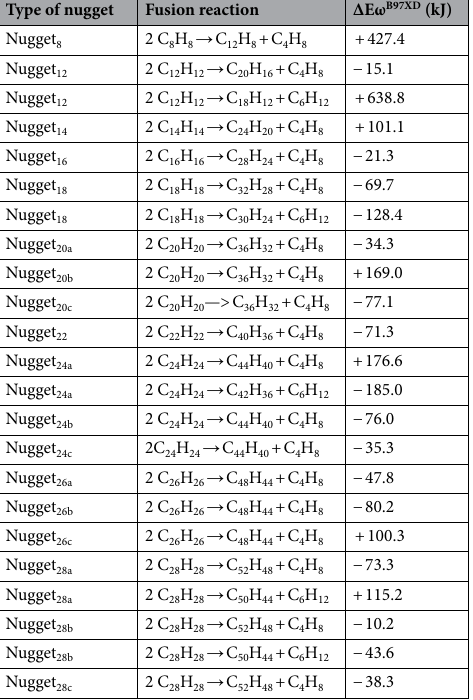
Table 4. Energy values of the most stable fusion reactions between two identical nuggets, either via square faces releasing C 4 H 8 , or, whenever possible, via planar hexagonal faces releasing C 6 H 12 . All values were calculated by employing the level of calculation